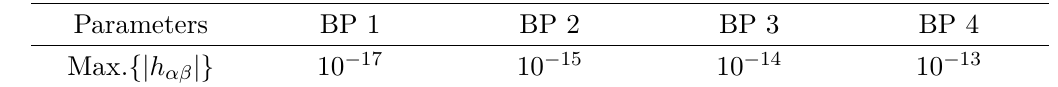
Table 3 . Maximum value of charged leptons’ coupling with Majoron obtained for the different benchmark